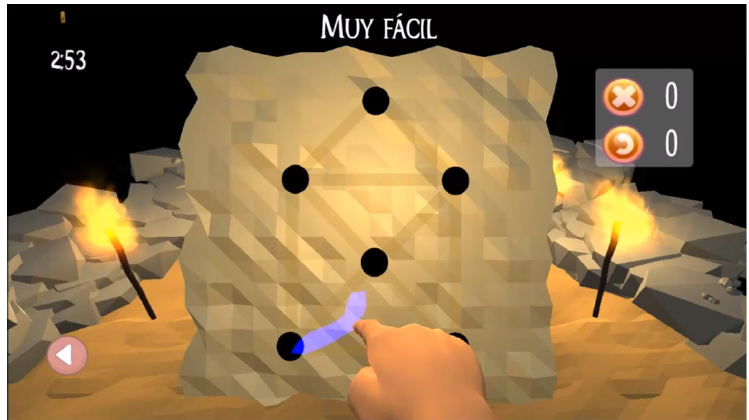
Figure 4. Virtual application Explorer included in RehabHand prototype.